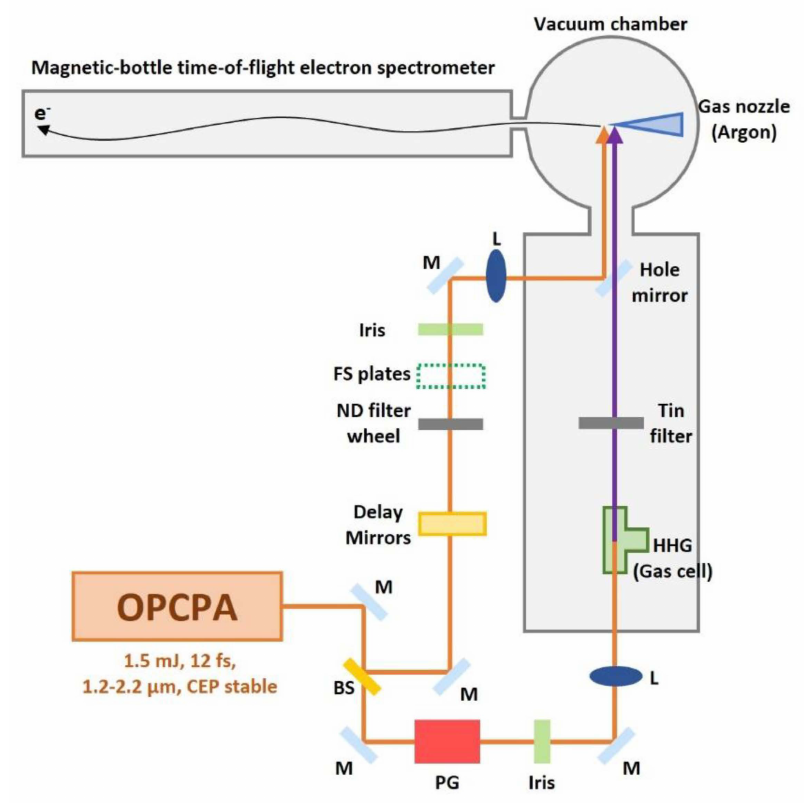
Figure 4. Schematic illustration for argon Auger decay measurement using isolated X-ray attosecond pulse and a long magnetic-bottle time-of-flight electron spectrometer for higher spectral